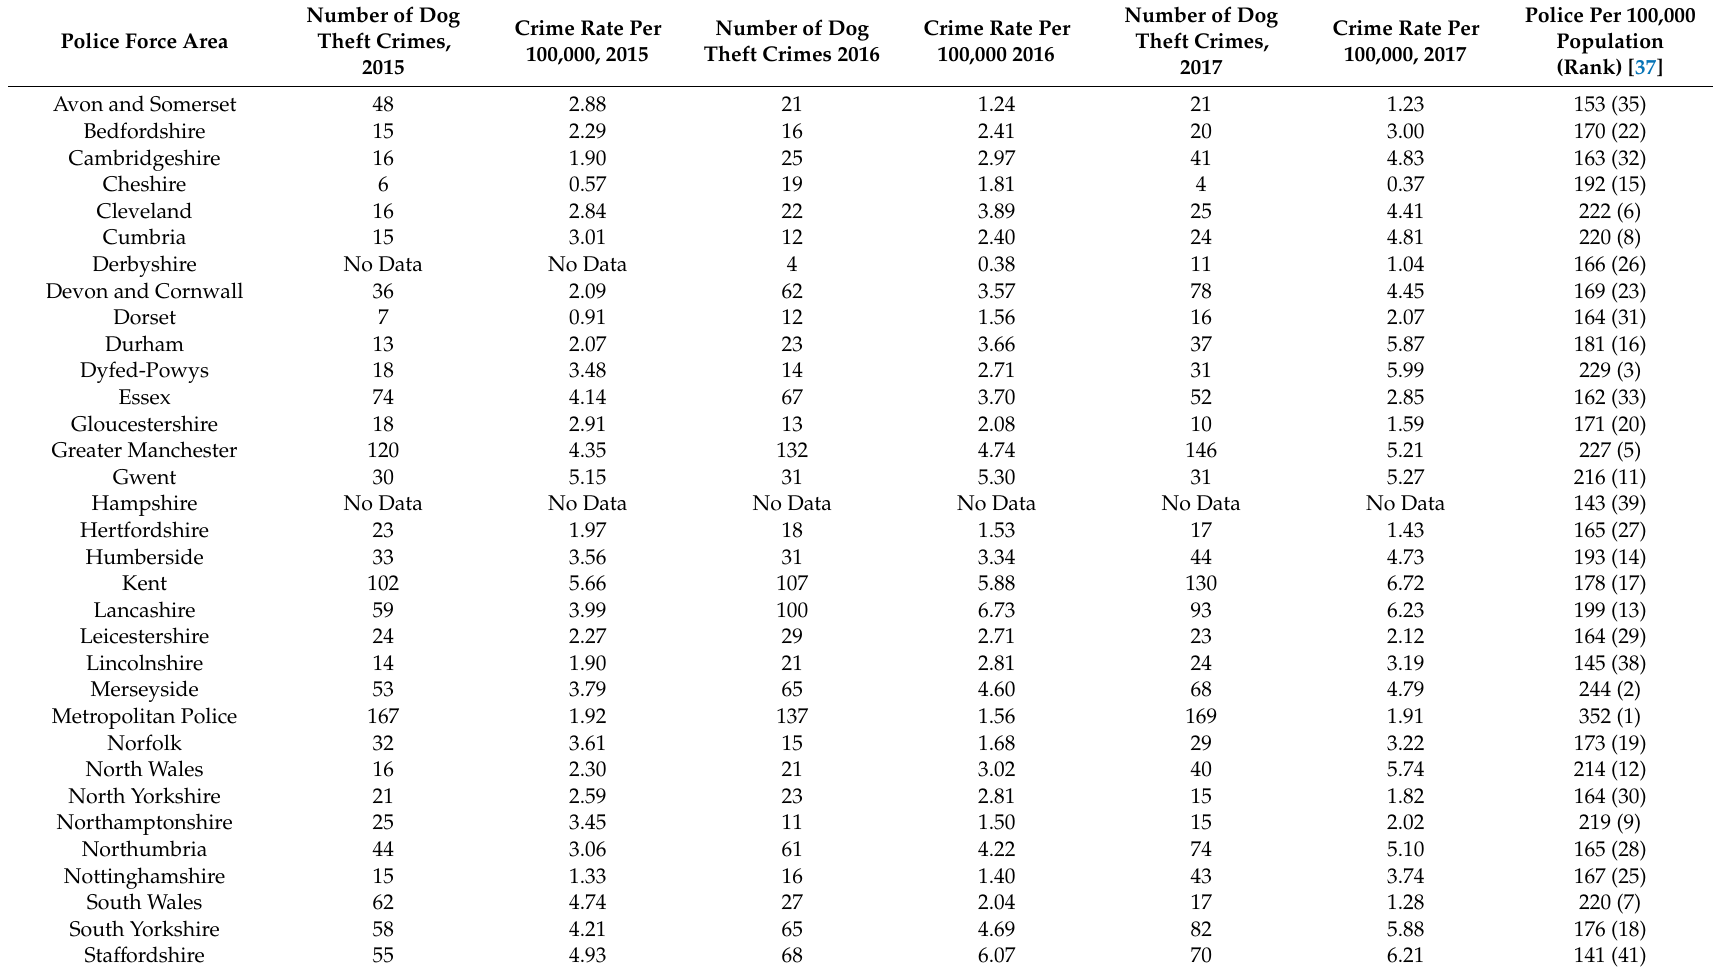
Table 4. FOI from 2015, 2016, and 2017 with associated crime rates per 100,000